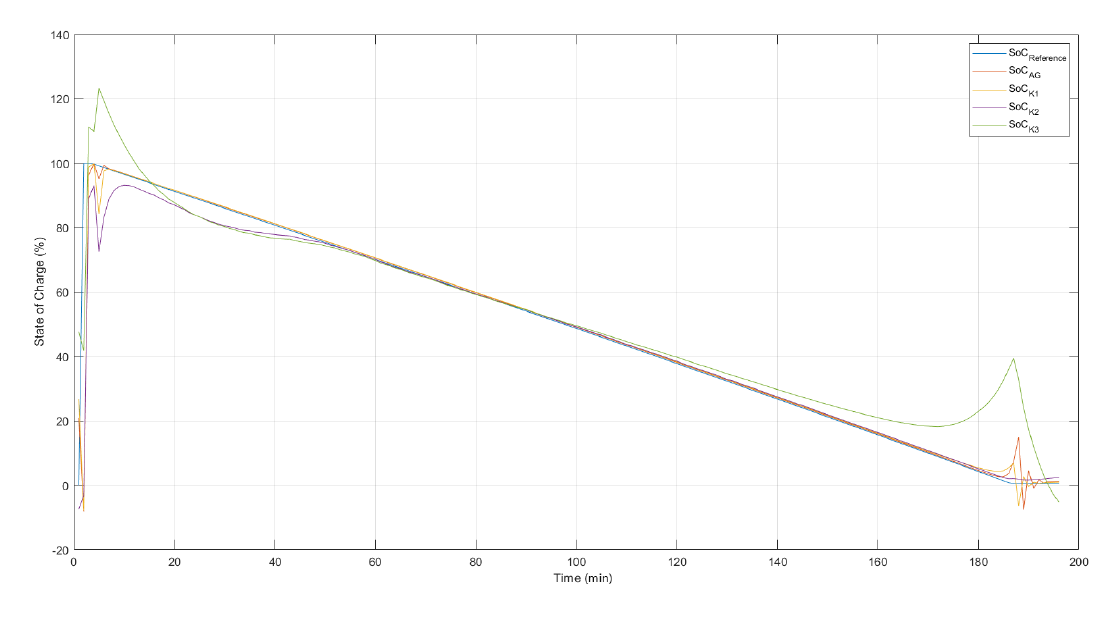
Figure 7. Validation of ANN models. State of Charge—training result without the presence of noise and outliers.